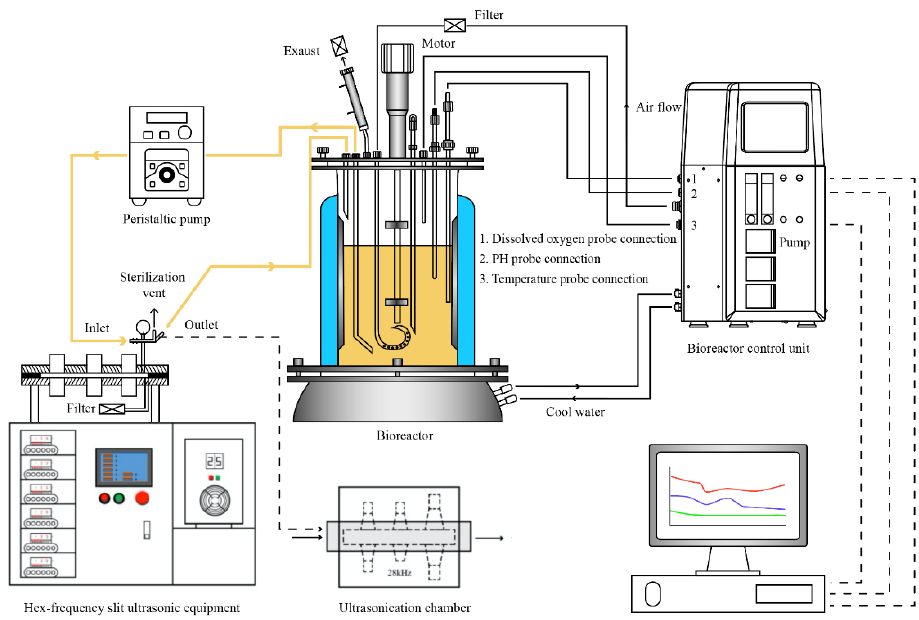
Figure 1. External ultrasound irradiation of broth in a recycle bioreactor. Pre-cultured seed (120 mL, 24-h seed culture) was inoculated into 1.5 L sterilized fer- mentation medium with an initial pH of 6.8. Under the conditions of 0.05 MPa pressure, 5.0 SLPM ventilation, temperature (30 °C) and agitation (200 r/min), the level of dissolved oxygen (DO) dropped as expected (from 100% to 10% or less), monitored with a DO elec- trode (Mettler Toledo ISM). A Mettler Toledo ISM pH electrode was used to determine changes in pH during cultivation. Afterward, pH was maintained at 4.0 by automatically adding NH 3 solution (12.5%, v / v ) to the culture broth until end of the cultivation. After 30 h of inoculation, the fermented broth was ultrasonically treated under the conditions of 28 kHz, 280 W/L and 0.37 W cm − 2 for 1 h. These conditions were chosen based on preliminary experiments, including the screening of ultrasound frequency, power density and treatment time. Samples were collected after each treatment for eval- uation/analyses. Suspension (cells) flowing through the reaction chamber of ultrasonic equipment with no ultrasonic treatment was used as control. 2.3. Establishment and Assessment of Fermentation Kinetic Models The original and mutant strains were subjected to activated culture and then trans- ferred to 3-L-jar fermenter. The fermentation culture and ultrasonic treatment were car- ried out under the fermentation parameter conditions (detailed in Section 2.2). For the control group, the sample was treated in same manner (as described) but without soni- cation. The samples of mycelium and fermentation broth were picked for measuring bio- mass and ε -polylysine production, respectively, every 12 h within 120 h. The fitted equa- tions were predicted and compared to illustrate the variations in the fermentation kinetics of biomass and ε -PL production with time. The logistic model is a typical S-shaped curve, indicating the exponential growth of bacteria. The logistic equation was used as an alter- native empirical function in this study. The growth pattern of S. albulus meets the basics of logistic regression [28]. A custom function (Equation (1)) was used to conduct non-lin- ear fitting (least squares) for the biomass. Previous studies have shown that the formation of ε -PL is partially coupled with cell growth according to the relationship between the formation of ε -PL and cell growth [28]. Our initial data indicated the synthesis of ε -PL showed a certain synchronization with cell/microbial growth at early stages of fermenta-